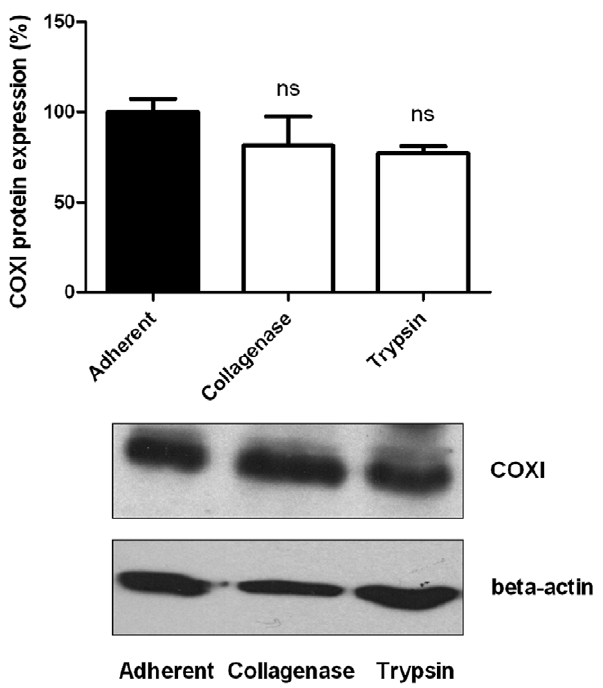
Figure 5. Effect of detachment procedures on COXI protein expression. Trypsinized cells (n=3) or collagenase-treated cells (n=3) have similar mitochondrial COXI protein levels than adherent cells (n=3) (ns, p . 0.05 (one way ANOVA) compared to adherent cells). Data are expressed as means 6 SEM.